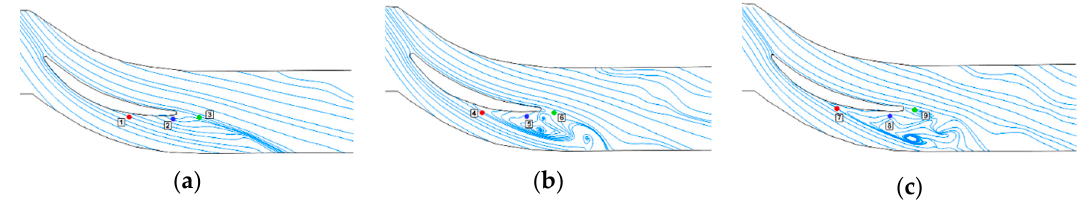
Figure 20. Location of monitor points at different spans: ( a ) 10% span; ( b ) 20% span; ( c ) 30% span.